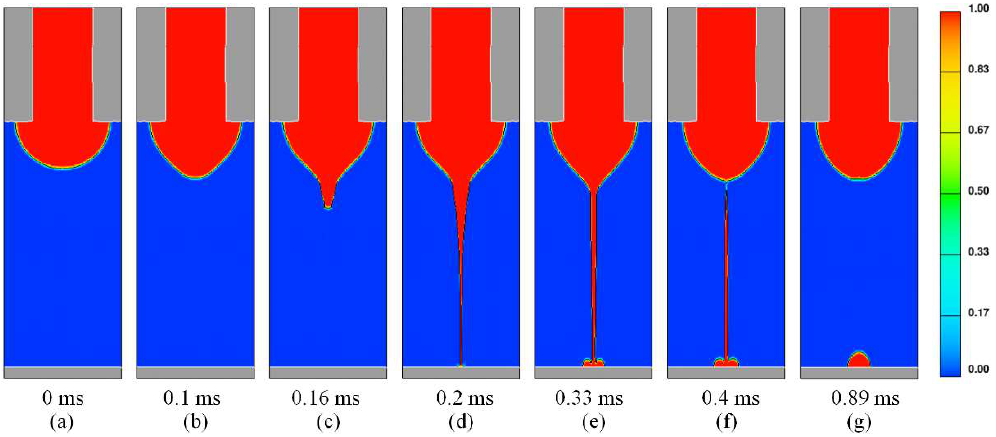
Figure 3. ( a – g ) Volume fraction distribution at seven representative moments during a whole injection